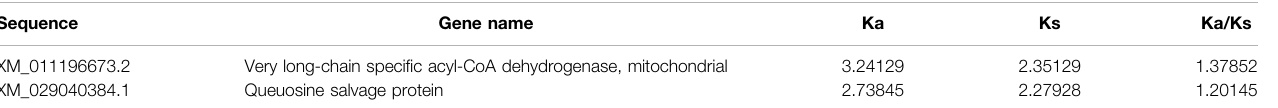
TABLE 3 | Strong positive select genes of Zeugodacus cucurbitae (Coquillett) and Ceratitis capitata (Wiedemann).